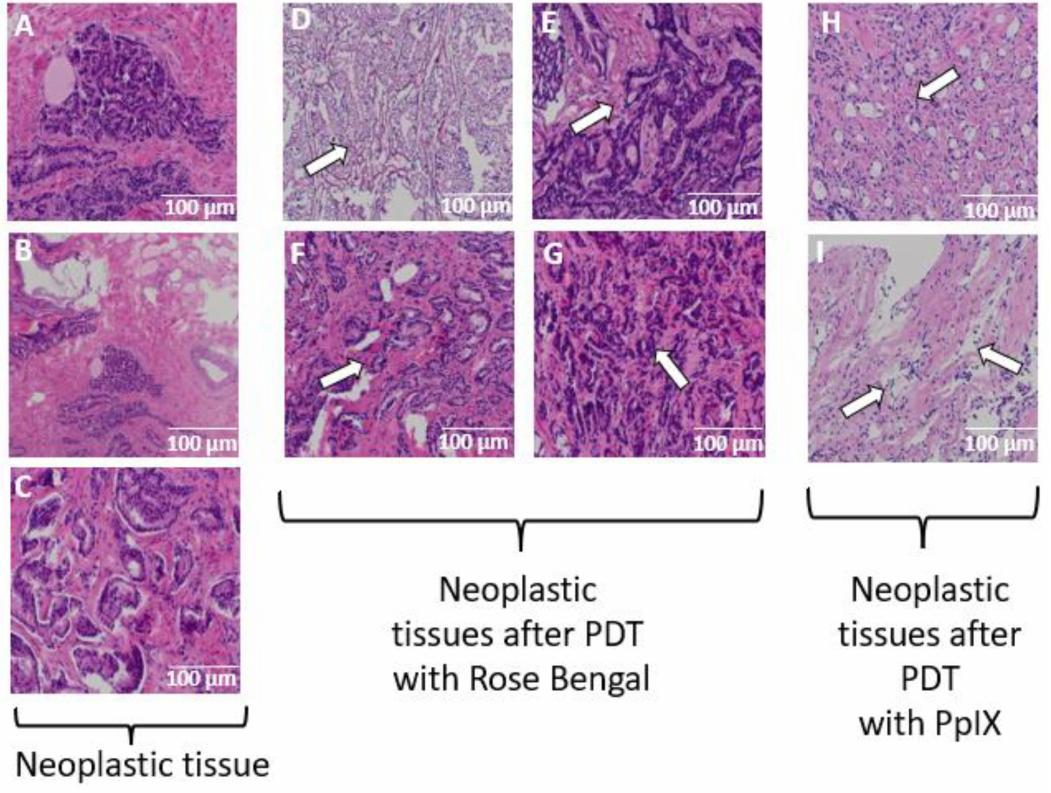
Figure 4. Prostate cancer tissue prior to (pictures A – C ) and after the PDT procedure with ( D ) 0.2 mM RB, ( E ) 0.3 mM RB, ( F ) 0.4 mM RB, ( G ) 0.5 mM RB, ( H , I ) and 3 mM